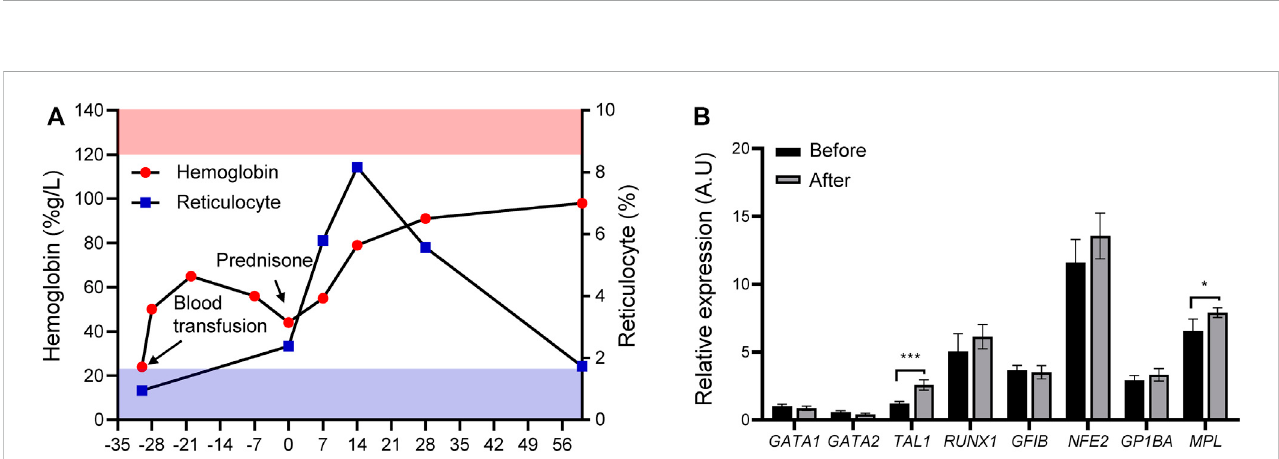
FIGURE 4 Treatment response and possible transcription reprogramming. (A) Treatment response after prednisone (upper panel, pink stripes, normal range of hemoglobin;lowerpanel,bluestripes,normalrangeofreticulocyte;solidredcircle,hemoglobin;solidbluesquare,reticulocyte)andtreatmentschema(Black arrows,bloodtransfusionandprednisone). (B) Expressionoferythroiddevelopmentaltargetgenes( TAL1 , MPL , GATA2 , RUNX1 , GFIB , GP1BA ,and NFE2 )before and after prednisone treatment. * p < 0.05, *** p < 0.001, **** p <